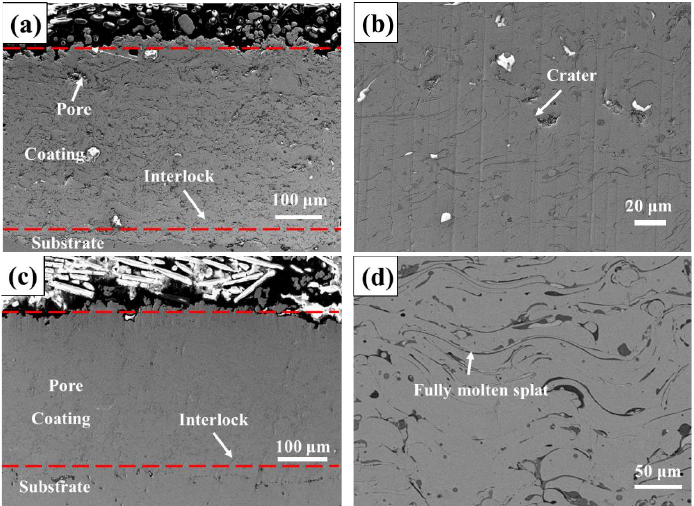
Figure 5. SEM images of high-entropy alloy coatings. ( a ) Low-magnification cross-section image of CS coating; ( b ) high-magnification cross-section image of CS coating; ( c ) low-magnification cross-section image of HVOF coating; ( d ) high-magnification cross-section image of HVOF coating.